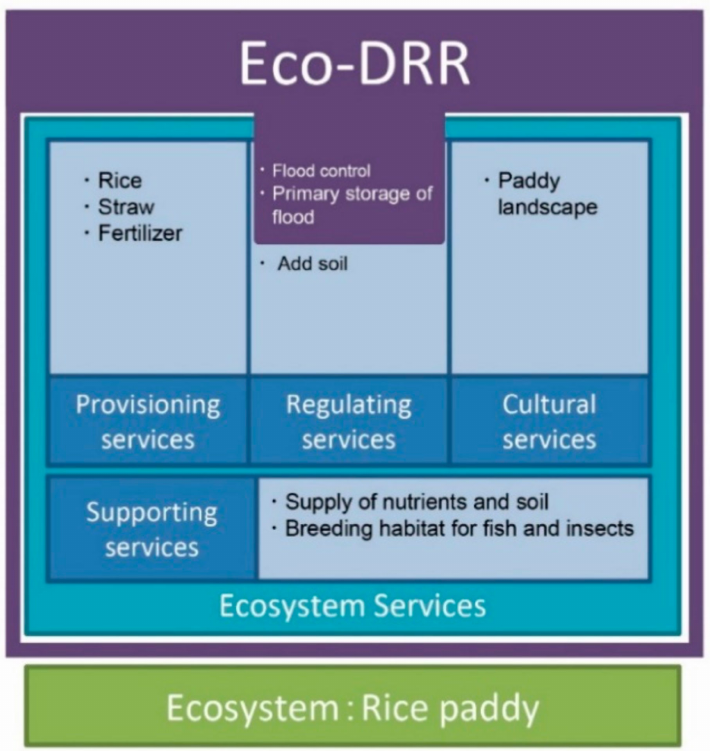
Figure 13. Eco-DRR and ecosystem services at Okawano flood plain.